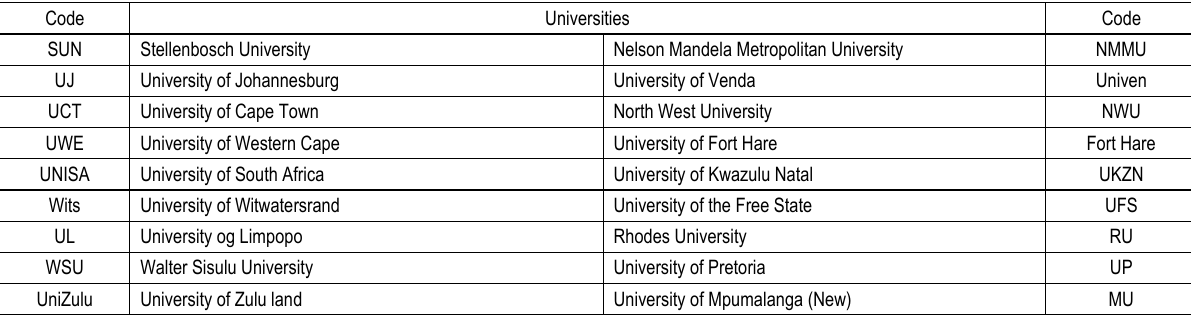
Table 1. Universities and universities of technology in South